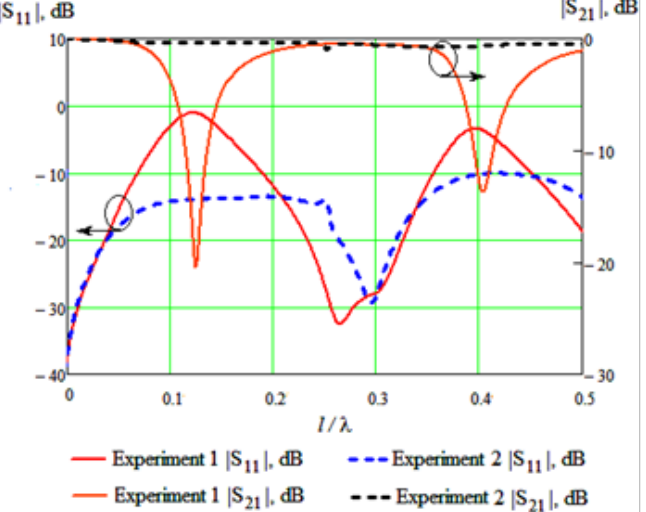
Fig. 11. Experimental dependences of insertion and return loss of SSL segment (circuit of Fig. 4 – experiment 1, Fig. 5 – experiment 2) at the ratio of the length to the wavelength affecting the signal in free